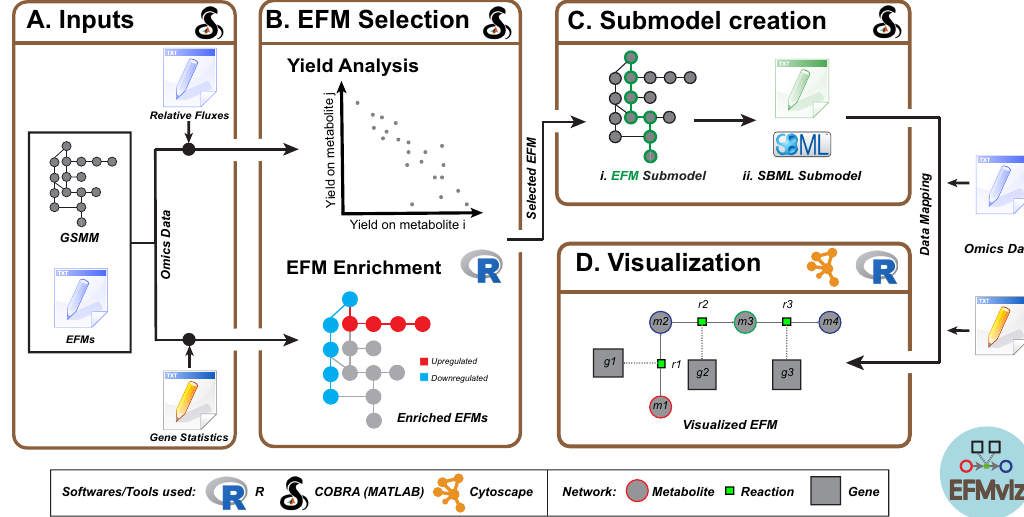
Figure 1. Overview of EFMviz, a new extension of COBRA Toolbox, for Elementary Flux Mode (EFM) visualization. Each box corresponds to a step of the workflow, and the tools/packages used are shown in the top right side of the boxes. ( A ) This workflow takes a Genome-Scale Metabolic Model (GSMM) and a list of EFMs calculated from this model as inputs. ( B ) Data-dependent EFM selection is performed through either yield analysis or EFM enrichment using omics data: in this case, a list of relative fluxes of reactions and differentially expressed genes repectively. ( C ) Once an EFM is selected, a “submodel” is created which is ( D ) visualized in Cytoscape where other omics data can also be